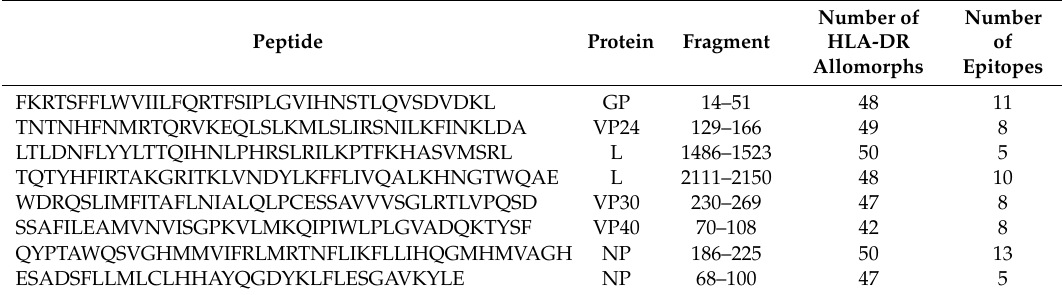
Table 2. Predicted CD4 + T-helper (Th)-epitopes in the sequences of Ebola virus proteins (antigens)